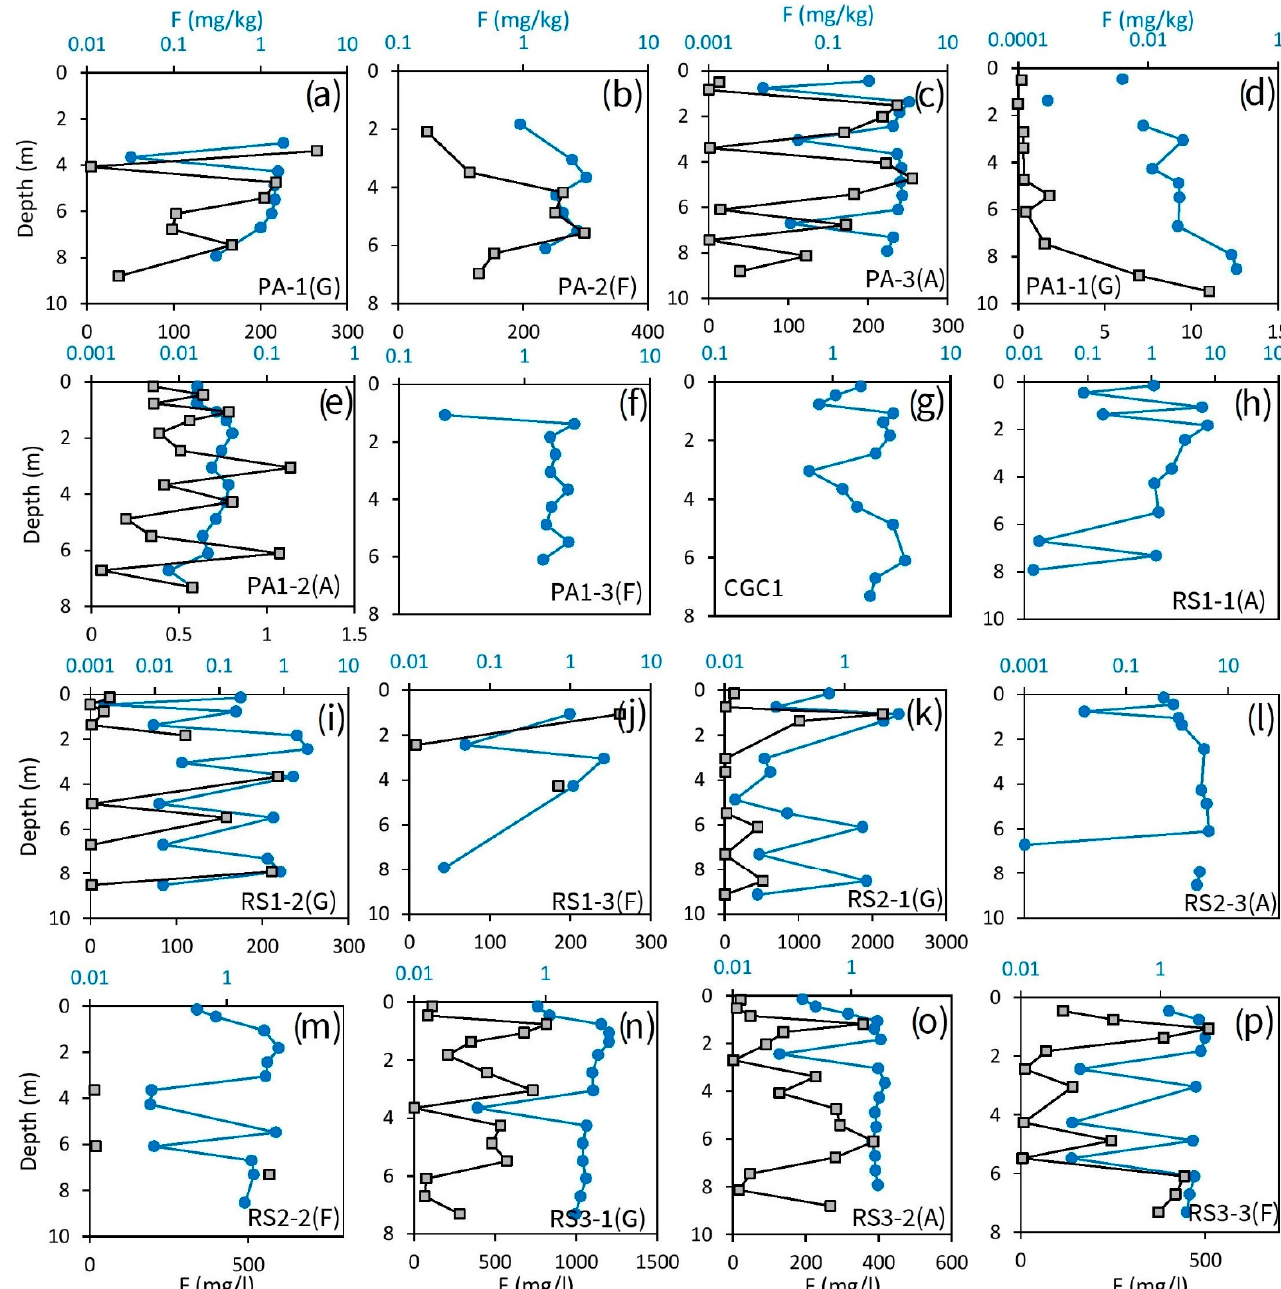
Figure 5. Unsaturated zone F depth profiles of the drilled sites; Blue circles and lines represent mg/kg values, whereas grey squares and black lines represent mg/L values. PA—Pleistocene Alluvium, CGC—Chotanagpur Gneissic Complex, RS—Residual Soils; letters in parenthesis indicate: G—Grasslands, A—Agricultural, and F—Forest land.